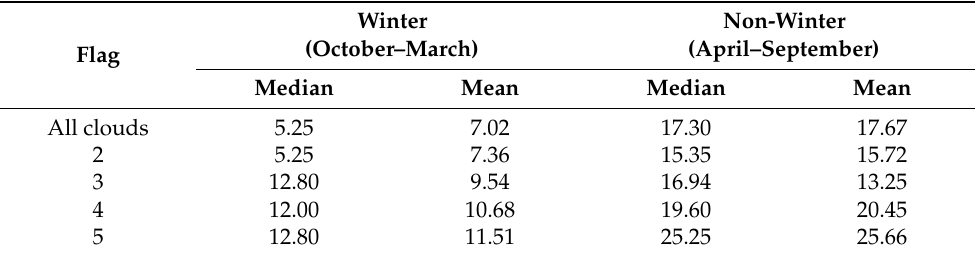
Table 11. Look-up table based on GF-7 data. Values are expressed in cm.